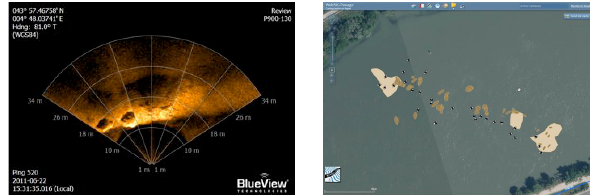
Figure 6. Acoustic camera results, showing the piers residues